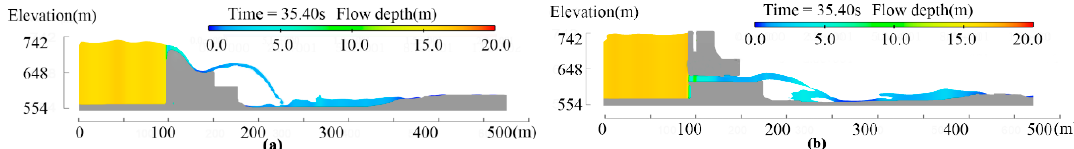
Figure 10. Pressure distribution under the normal water level. (a) pressure distribution at T = 5 s; (b) pressure distribution at T = 10 s; (c) pressure distribution at T = 20 s; (d) pressure distribution at T = 30 s; (e) pressure distribution at T = 40 s; (f) pressure distribution at T = 50 s. One significant practical value of the joint flood discharge with the surface spillway and the bottom outlet is their highly efficient flow energy dissipation capacity. Collision and energy dissipation occur after the two jets meet, and the deflecting flow consumes a large amount of energy. This could prevent the downstream channel from severe erosion and stabilize the main flow stream